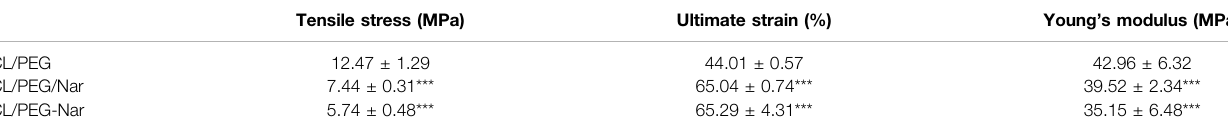
TABLE 2 | Mechanical properties of PCL/PEG, PCL/PEG/Nar, and PCL/PEG-Nar nano fi ber membranes.